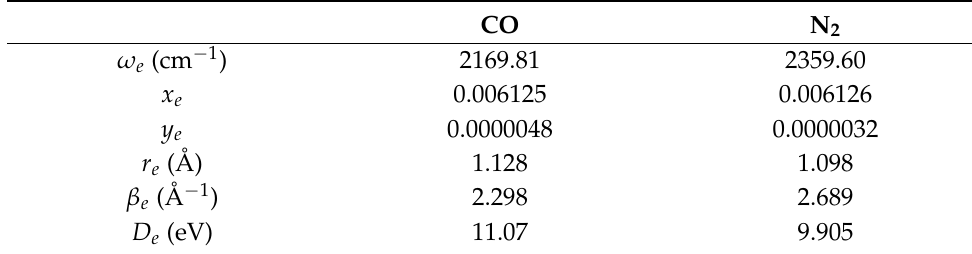
Table 1. Molecular constants for CO and N 2 [34].